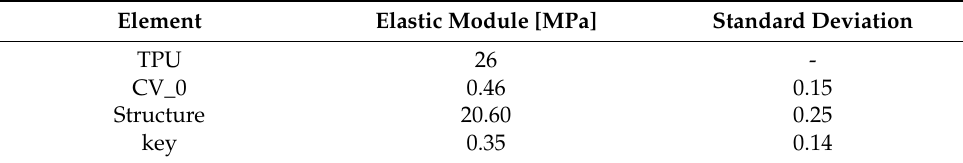
Table 5. Results obtained from the compression test on the printed keyboard.